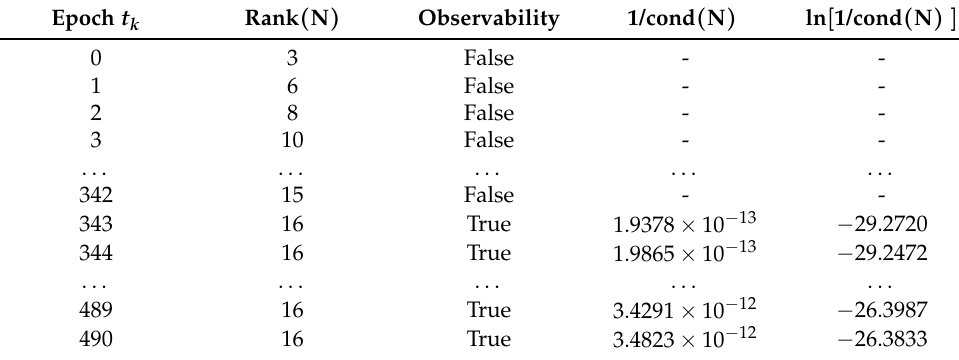
Table 5. Observability test results of case IV